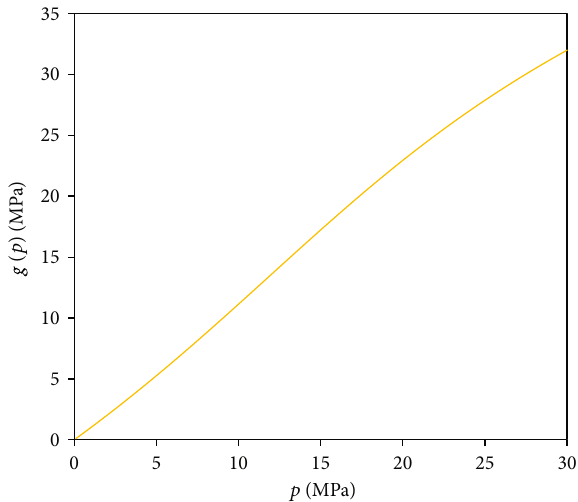
Figure 4: The relation curve of s ð p Þ vs. p for the normal pressure cases.